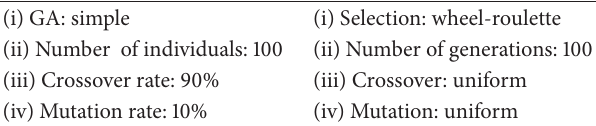
Table 5: Genetic algorithm configuration.